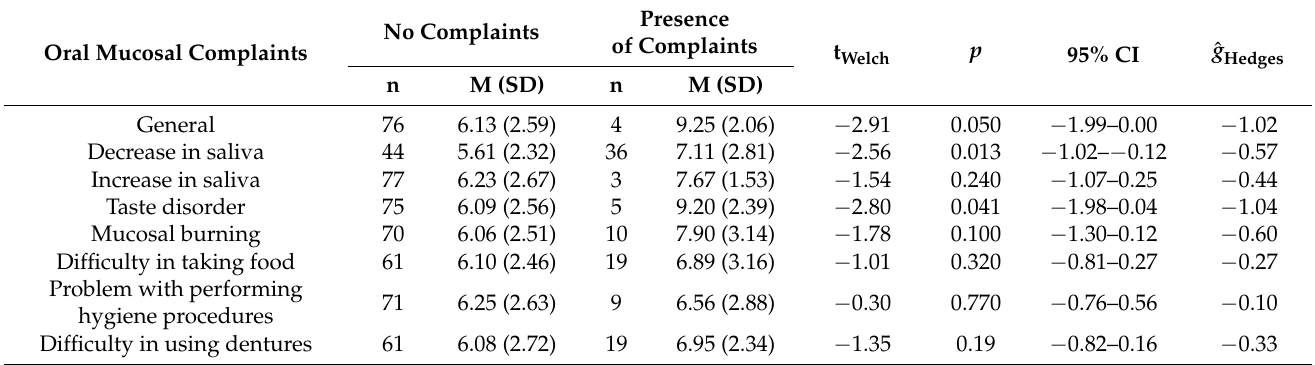
Table 7. Relationship between oral mucosal complaints and the number of medications.